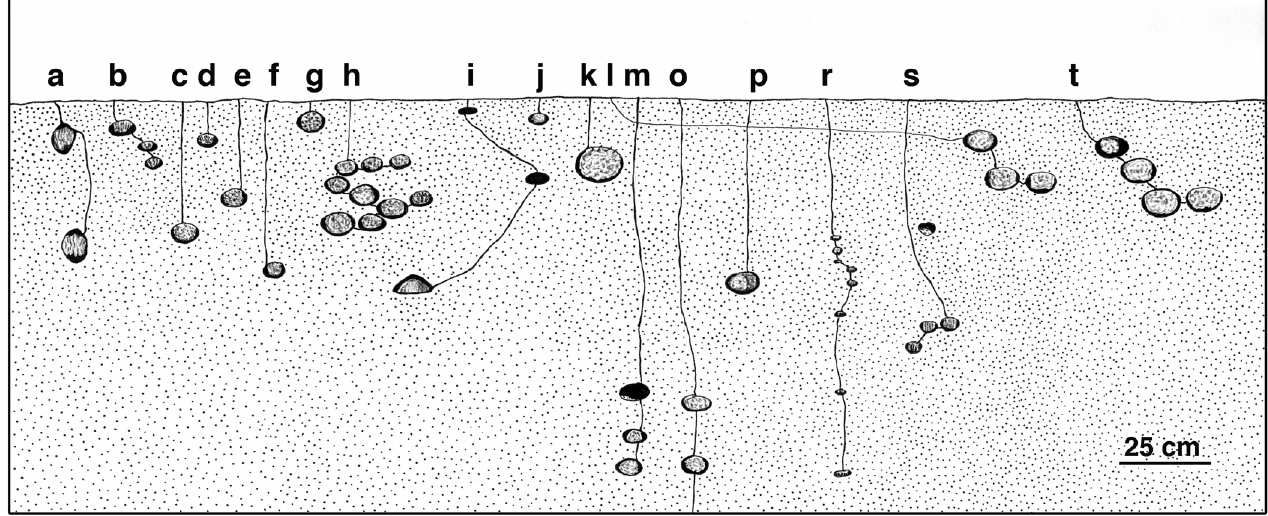
Fig 3. Schematic representation of nests of various ground-nesting fungus-farming ants. a . Trachymyrmex septentrionalis (Tschinkel,